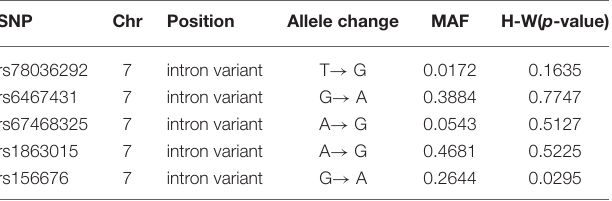
TABLE 2 | The characteristics of targeted SNP.